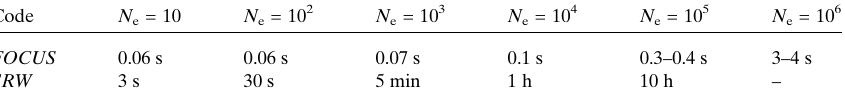
Table 2 Comparison between FOCUS and SRW simulation time as a function of the number of electrons in the beam N e